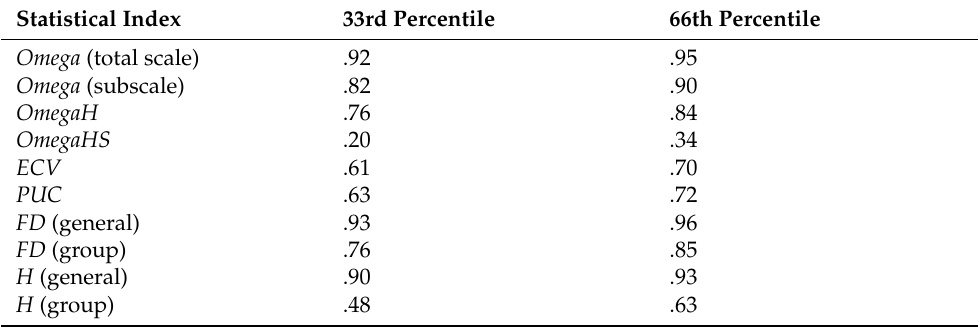
Table 1. Estimated 33rd and 66th percentiles for bifactor indices using Rodriguez et al. (2016b) Table 2